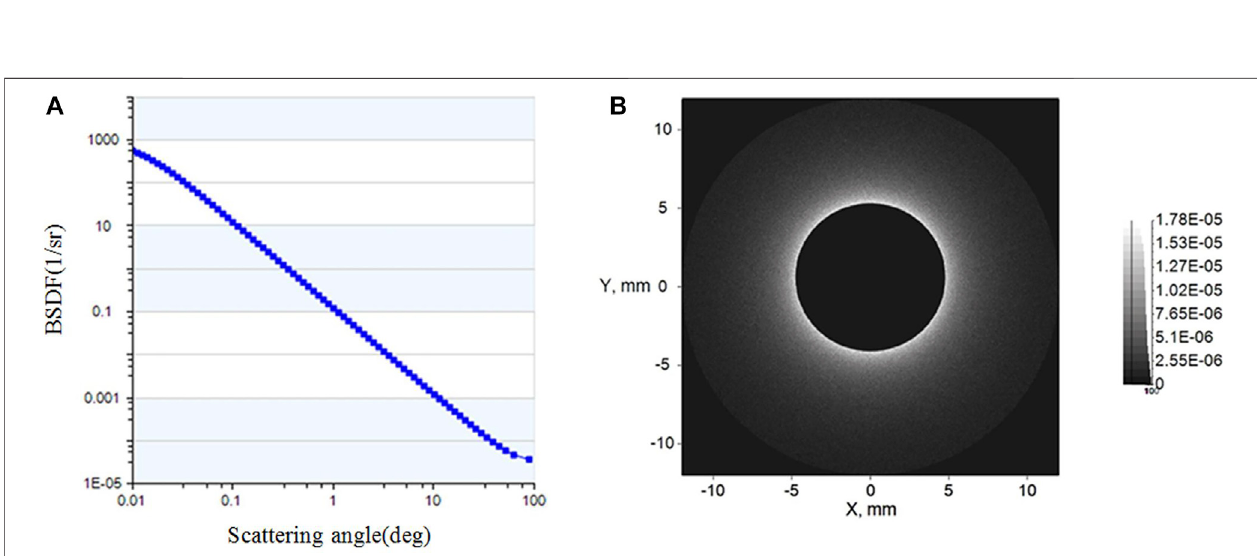
FIGURE 6 | Scattered stray-light simulation results from surface errors of M1 at 121.6 nm. (A) BSDF curve as a function of the scattering angle for M1 due to a surface roughness of 0.3 nm at 121.6 nm. (B) Stray-light distribution at the focal plane (CMOS1).